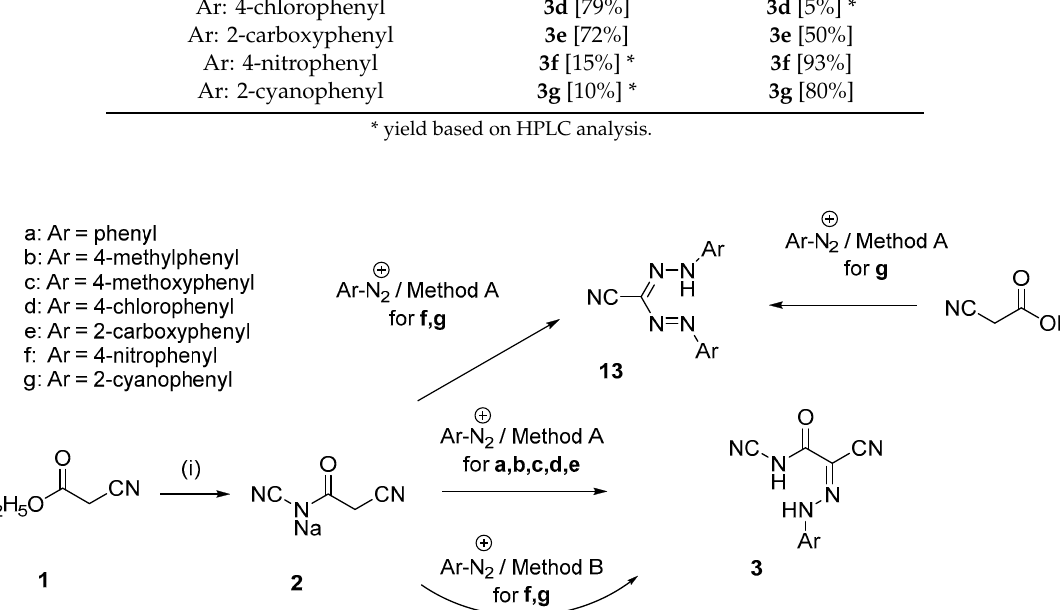
Scheme 1. Preparation of arylhydrazones 3 showing the formation of undesired formazans 13 for